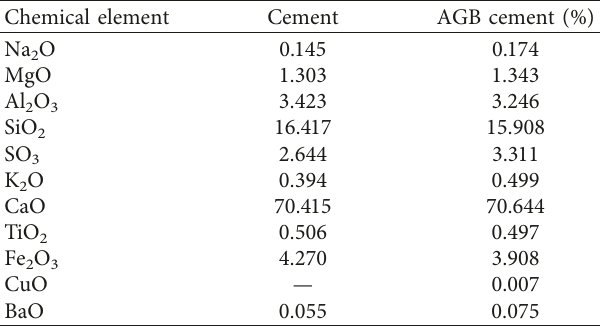
Figure 6: Carbonation penetration of concrete as function of